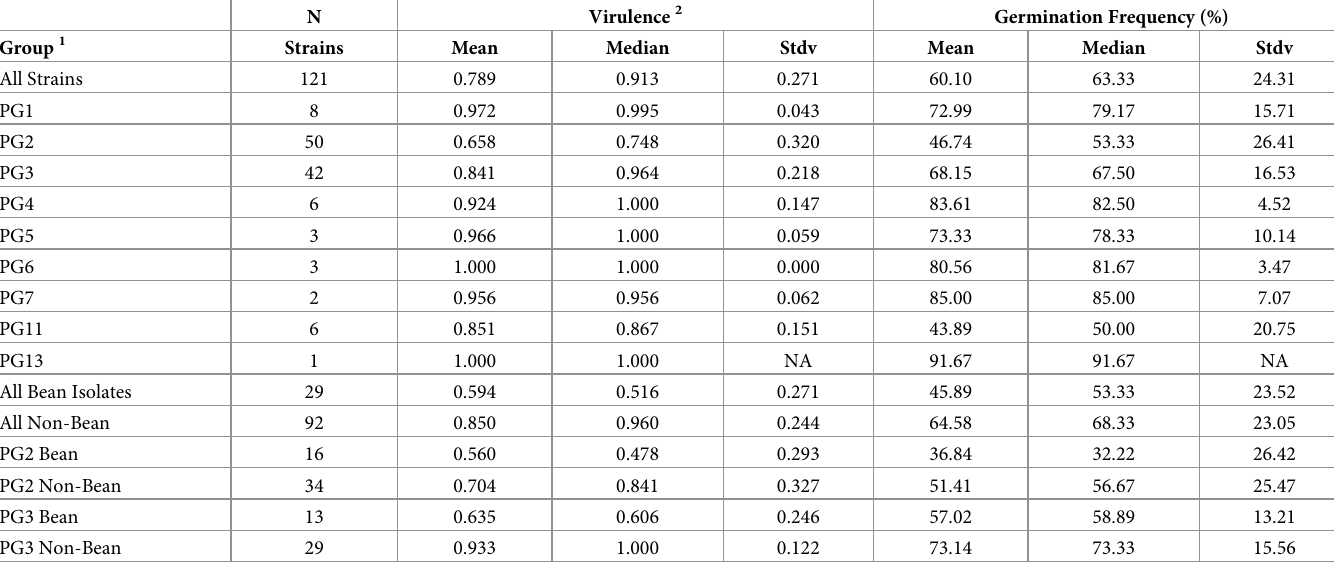
Table 1. Virulence and Germination Assay